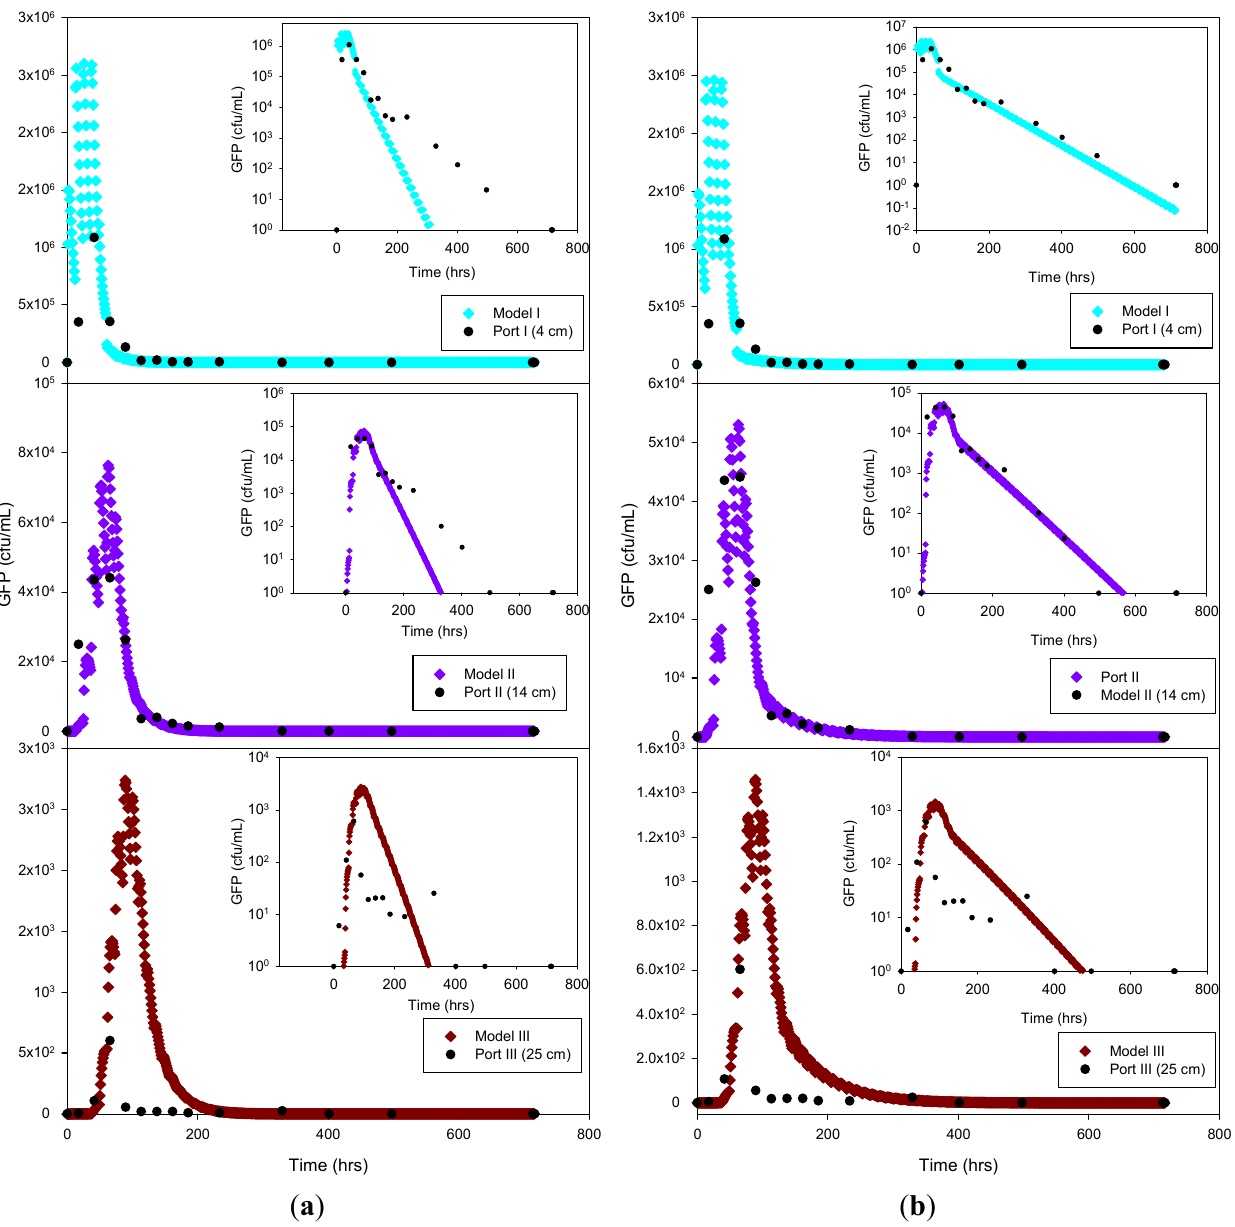
Figure 5. Experimental GFP E. coli data and HYDRUS optimization ( a ) and trial-and-error; ( b ) simulation for the sandy loam soil at 4 cm, 14 cm and 25 cm depth. The log-normal inserts emphasize the tailing